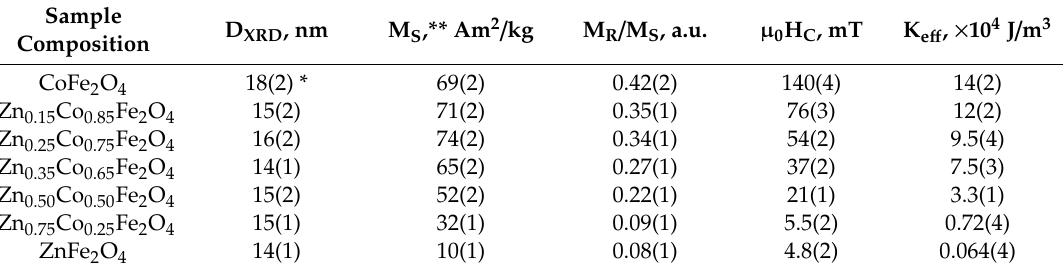
Table 1. The crystallite size (D XRD ), room temperature saturation magnetization (M S ), coercivity field ( µ 0 H C ), reduced remanent magnetization (M R / M S ) and e ff ective magnetic anisotropy (K e ff ).